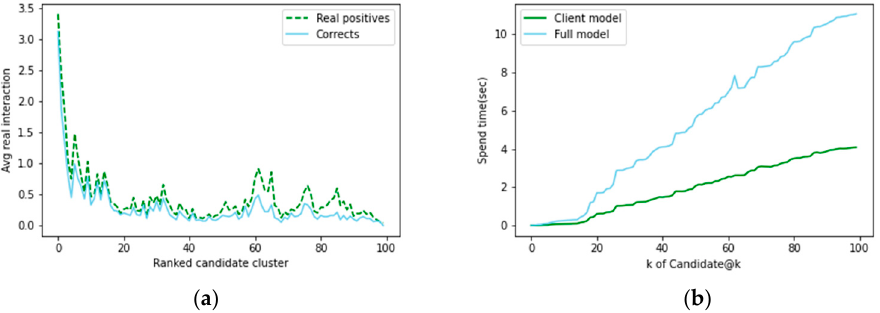
Figure 5. ( a ): Recommendation result graph according to clusters ranked by user. The x -axis is the preference ranking of centroids of clusters inferred by each user, and the y -axis means the average number of real positive interactions. ( b ): This is a graph measuring the consumed time to recommend a candidate group for a specific user according to a change in k using MovieDIRec+. Candidate@k means that the top k among the candidates for the user was used for recommendation. x -axis means k, and y -axis means time